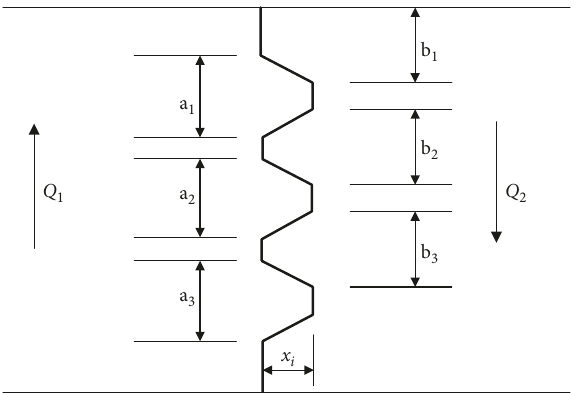
Figure 3: Shear bearing of mortise and tenon